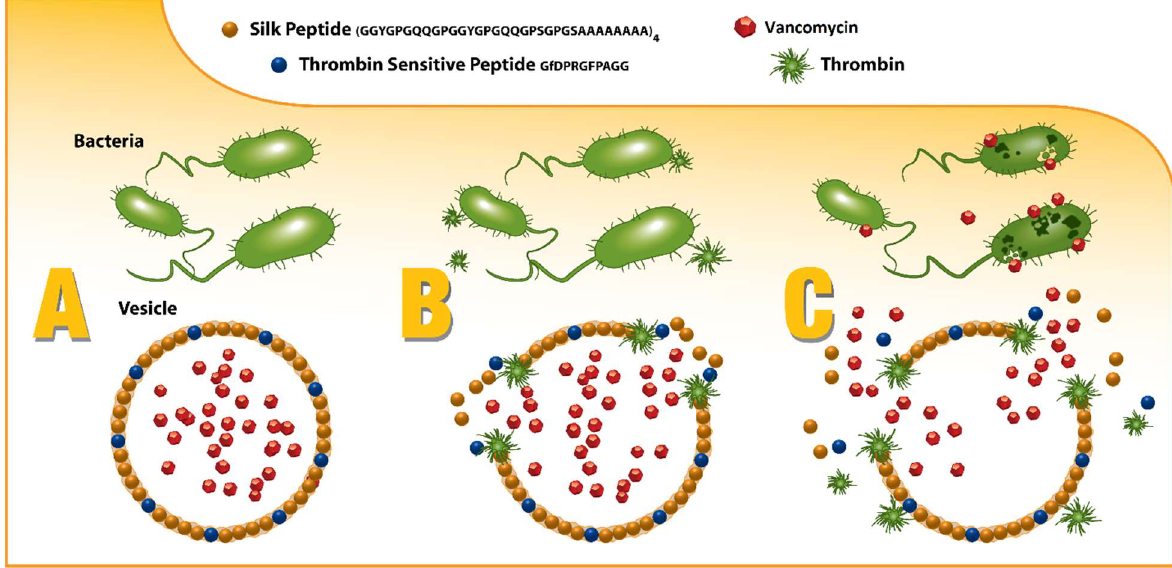
Figure 1. Graphical representation of the infection responsive release of the drug triggered by bacterial enzyme.